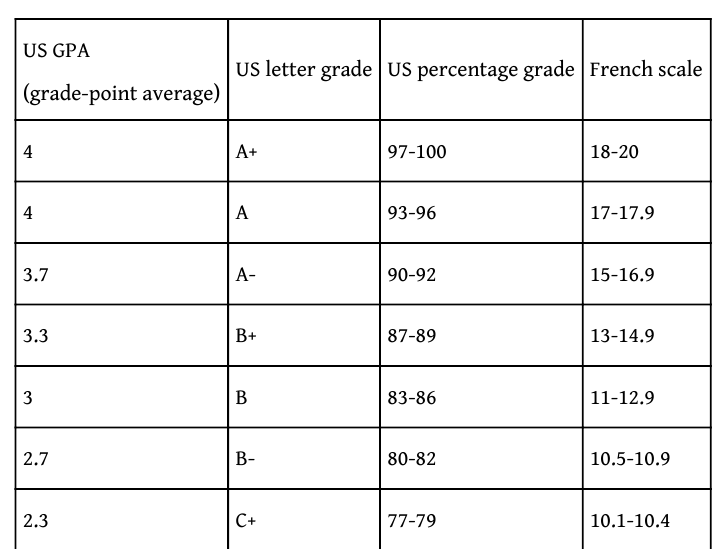
Table 2: Table of equivalence between grading systems